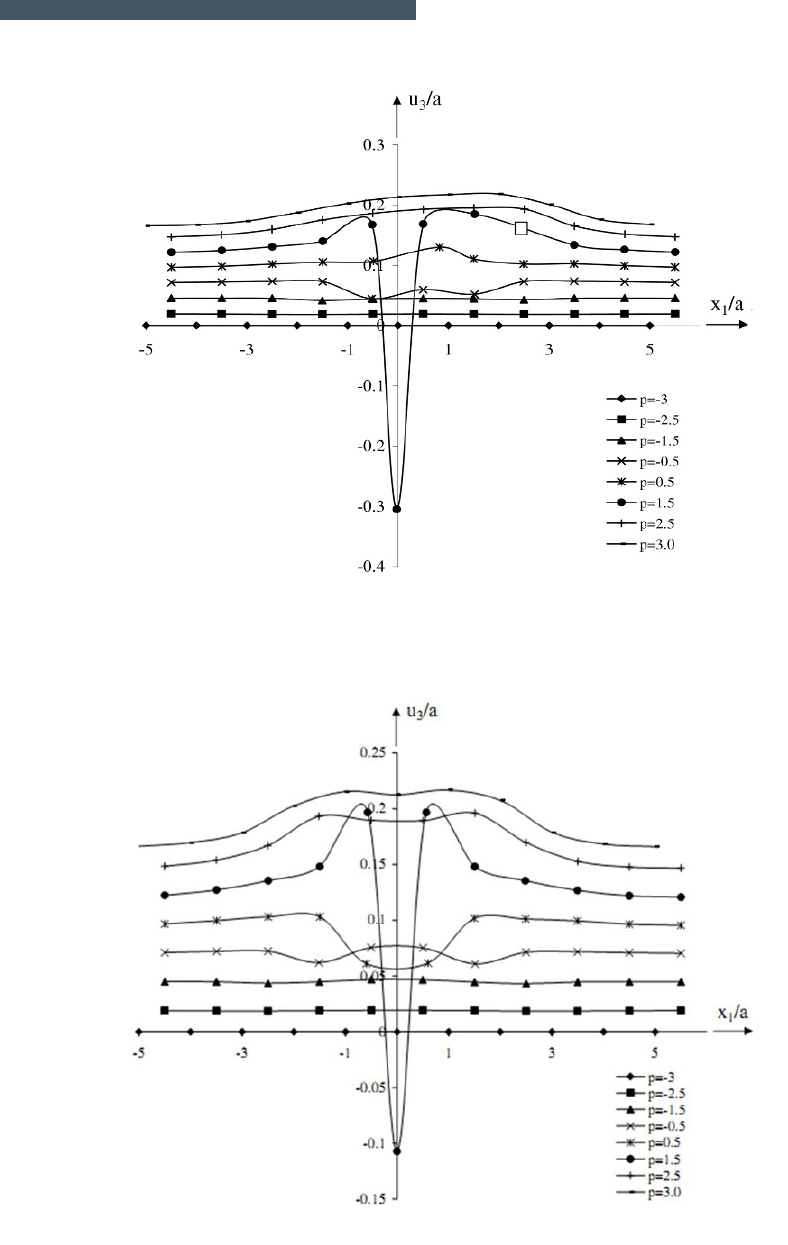
Figure 2. Lattice distortion within the (010) plane of an ultra-thin Cu film containing an OSIA at (0 , 0 , 1 . 5 a ; 1 . 5 a ) , pertinent to cases (a) I, and (b) II.